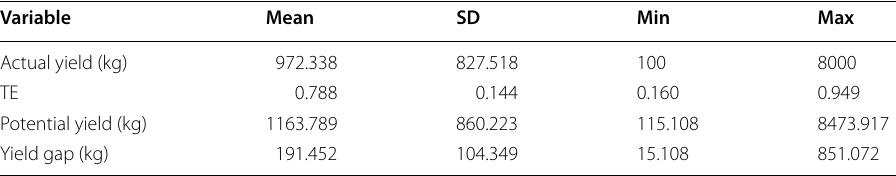
Table 3 Red pepper yield gap due to technical inefficiency Source : Own survey result